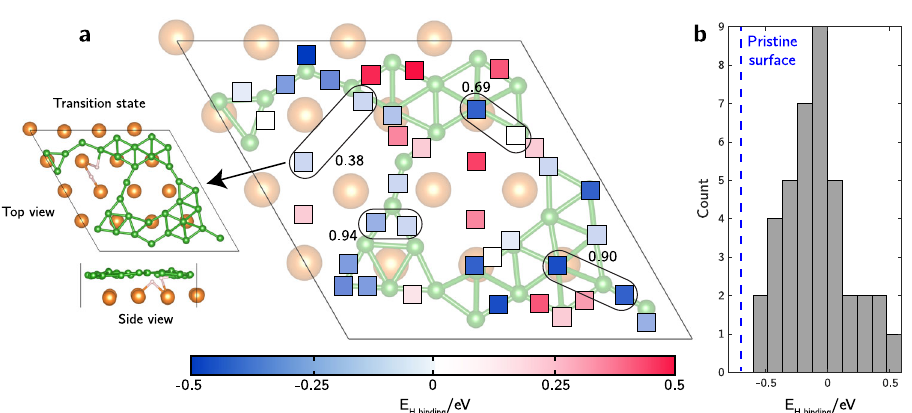
Fig. 6 Implications for MgB 2 hydrogenation. a Energy map of atomic H binding on the LM4 con fi guration of MgB 2 , with squares indicating locally stable binding sites colored according to E Hbinding . Tested site pairs for dissociative H 2 adsorption are highlighted as black ovals, with corresponding dissociation barriers indicated in eV. Top and side views of the transition state structure for dissociative H 2 adsorption at the Mg- B site pair are shown at left. Atom color codes: green: B, orange: Mg, pink: H. b Histogram of E Hbinding on the LM4 con fi guration compared with the reference value for the hexagonal boron surface (vertical dashed line).